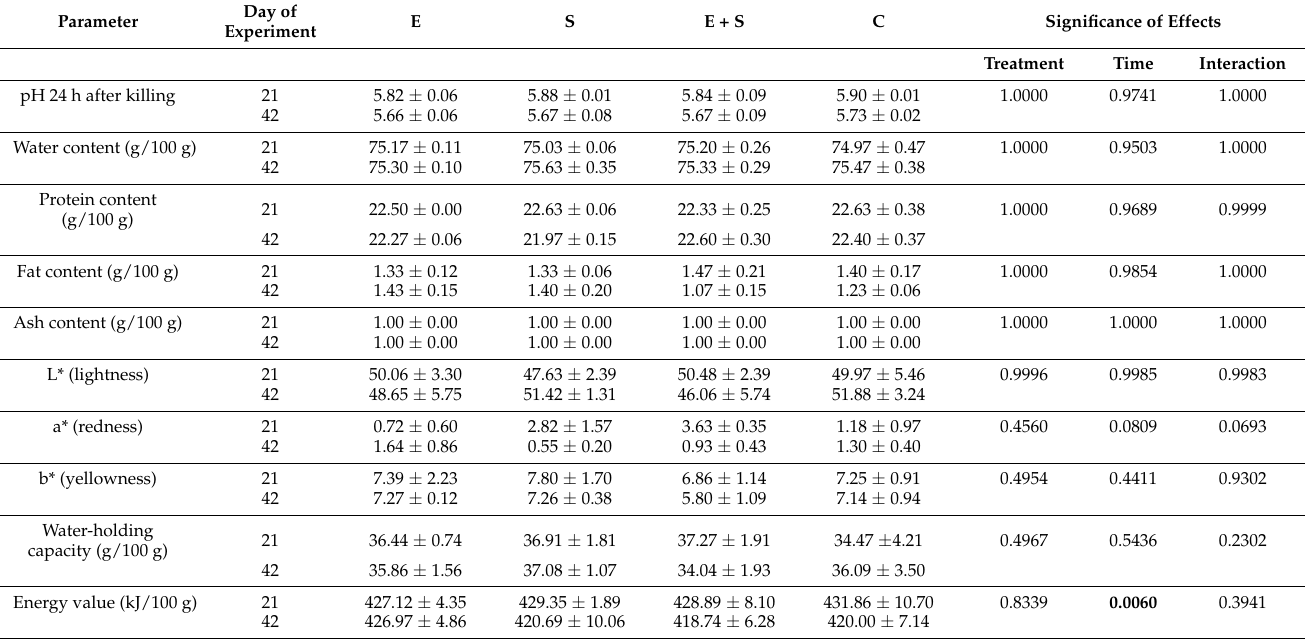
Table 2. The effect of Ent 7420 (E), sage extract (S) and their combinative (E + S) application on the meat physico-chemical characteristics of rabbits Longissimus thoracis and lumborum ( LTL ; mean ±